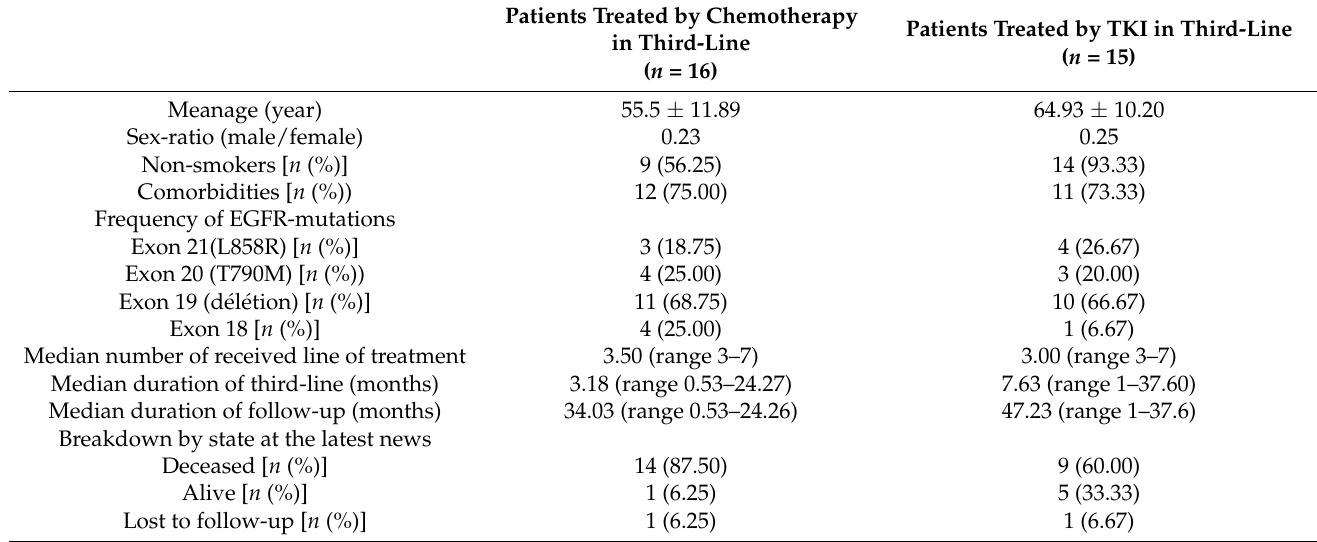
Table 1. Patients’ characteristic according to the third line of